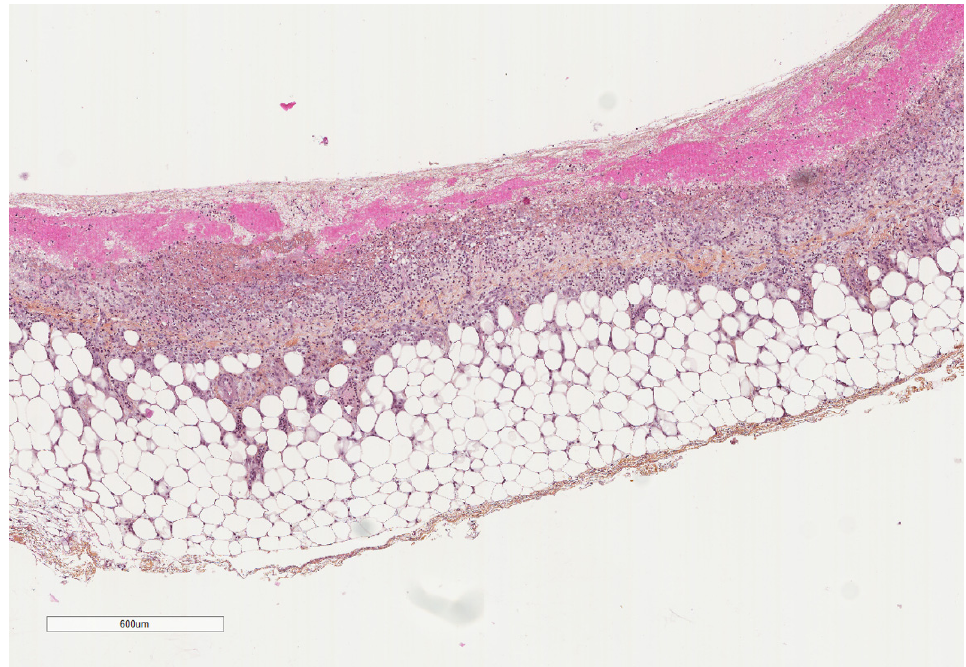
Figure 8. A parietal pleura biopsy showing a hemorrhagic layer in the pleural cavity (upper part) underlined by some inflammatory cells (see next figures for details); adipose tissue at the lower part. Hematoxylin, eosin, saffron staining (×40).